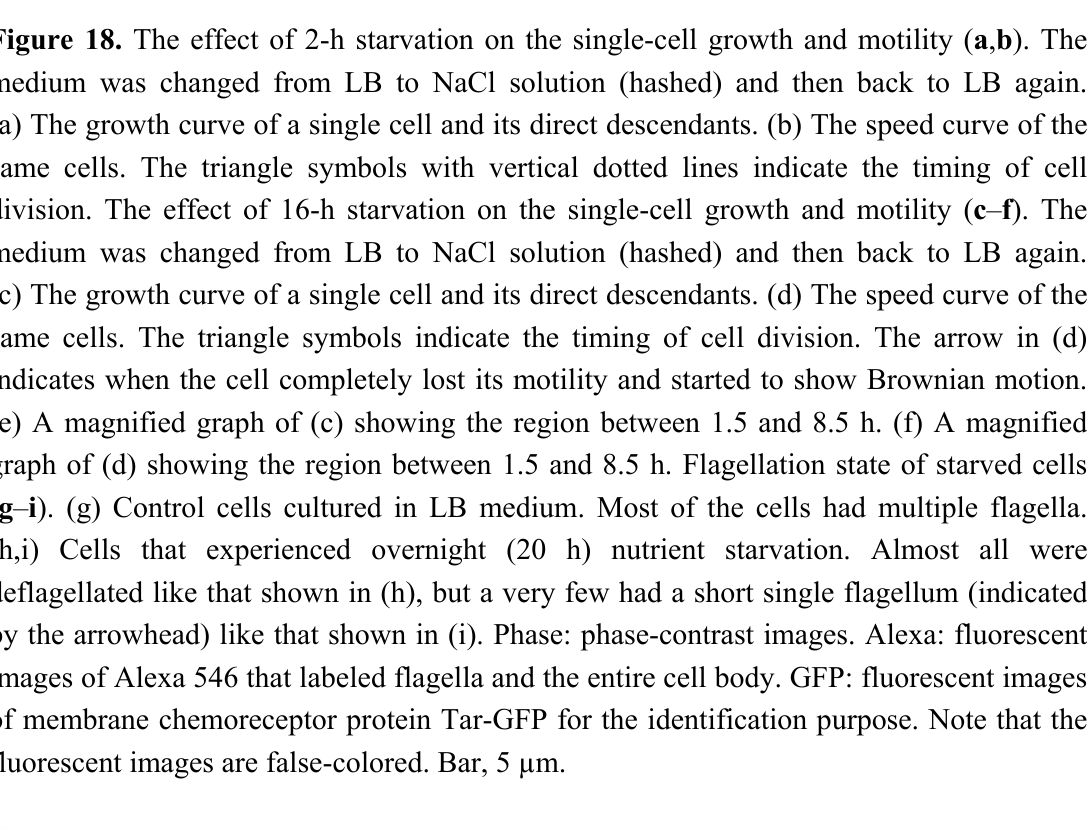
Figure 18. The effect of 2-h starvation on the single-cell growth and motility ( a , b ). The medium was changed from LB to NaCl solution (hashed) and then back to LB